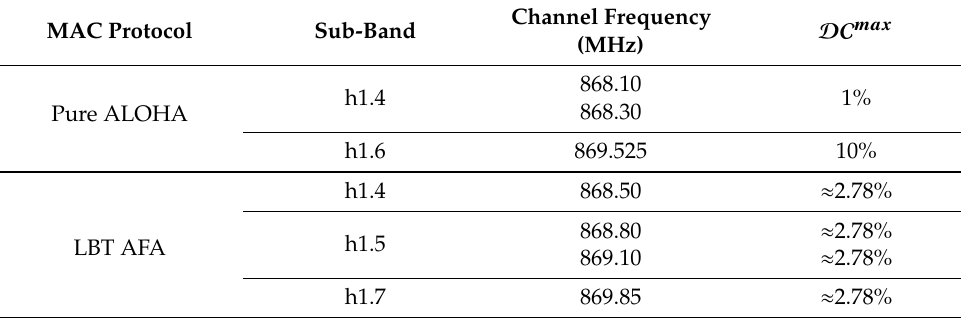
Table 5. SPC scenario—Configuration